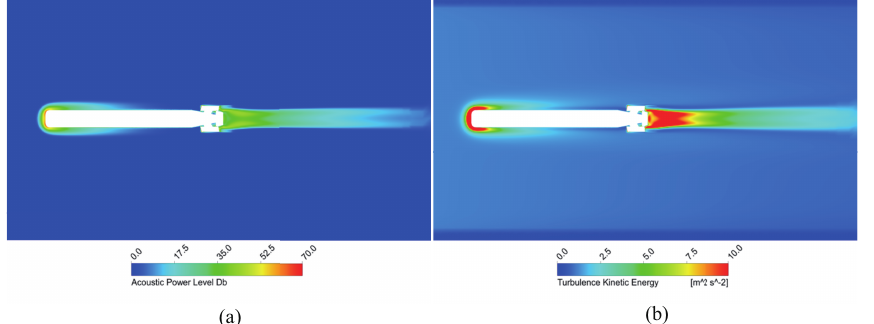
Figure 3. Steady-state calculation results. ( a ) Distribution of sound power level ( b ) Distribution of turbulent kinetic energy.